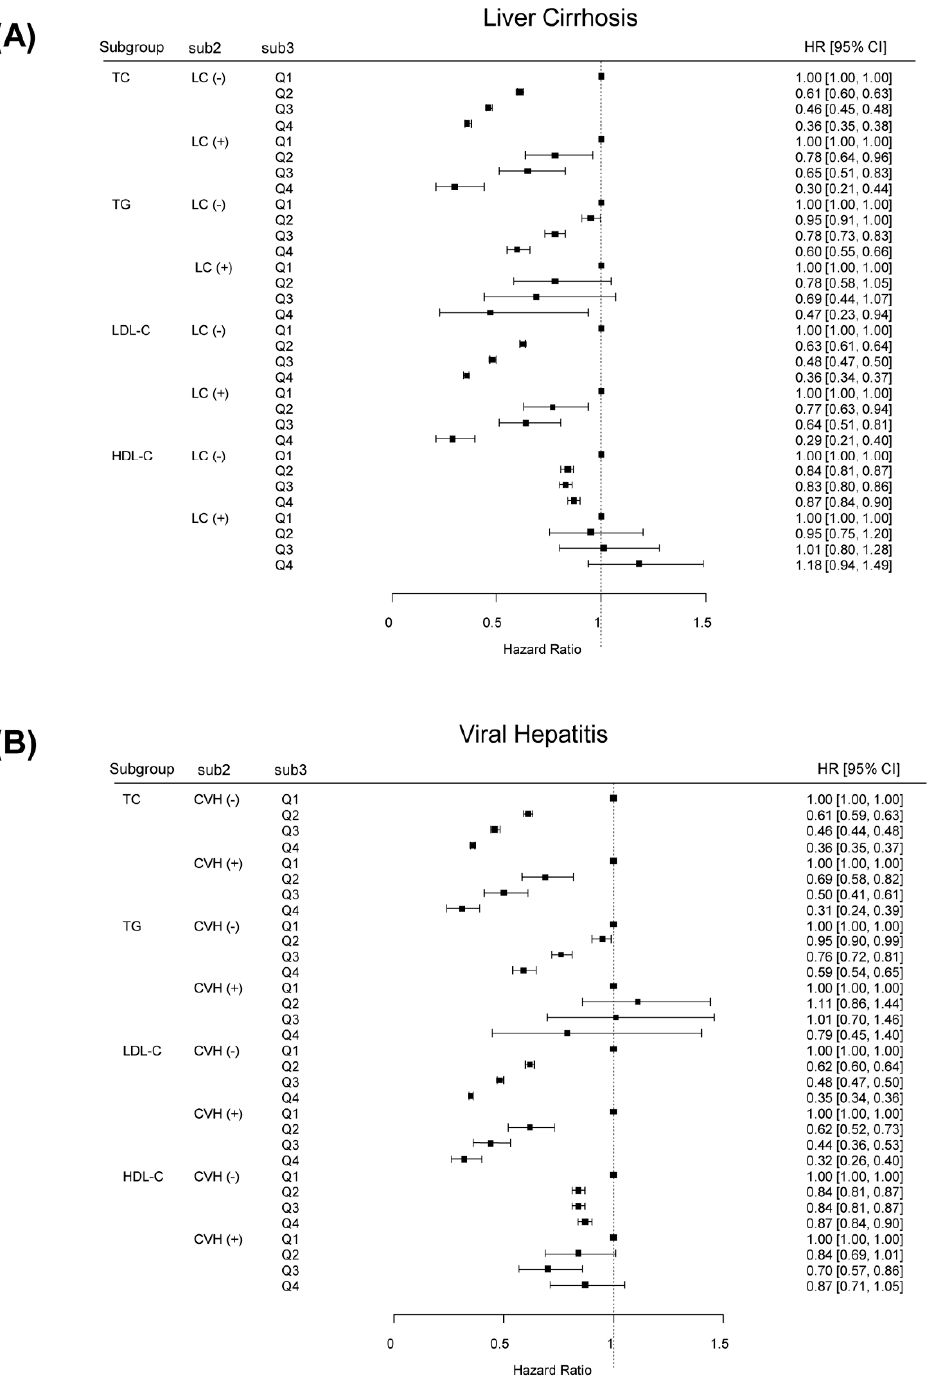
Figure 2. Adjusted HRs of HCC incidence according to lipid profile classification stratified by the presence of LC ( A ) or VH ( B ). HR, hazard ratio; HCC, hepatocellular carcinoma; LC, liver cirrhosis; VH, viral hepatitis.